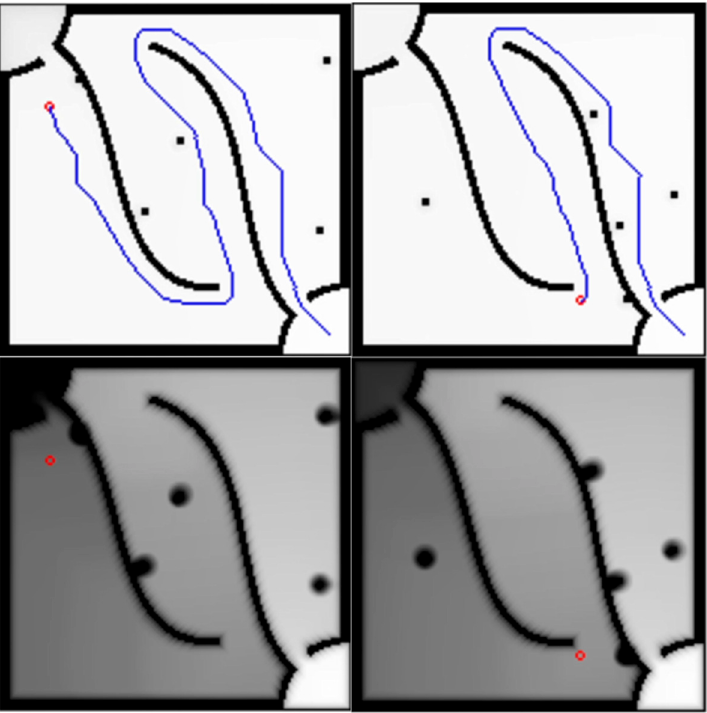
Figure 4. Real-time path planning with the distance cost to obstacles and walls.